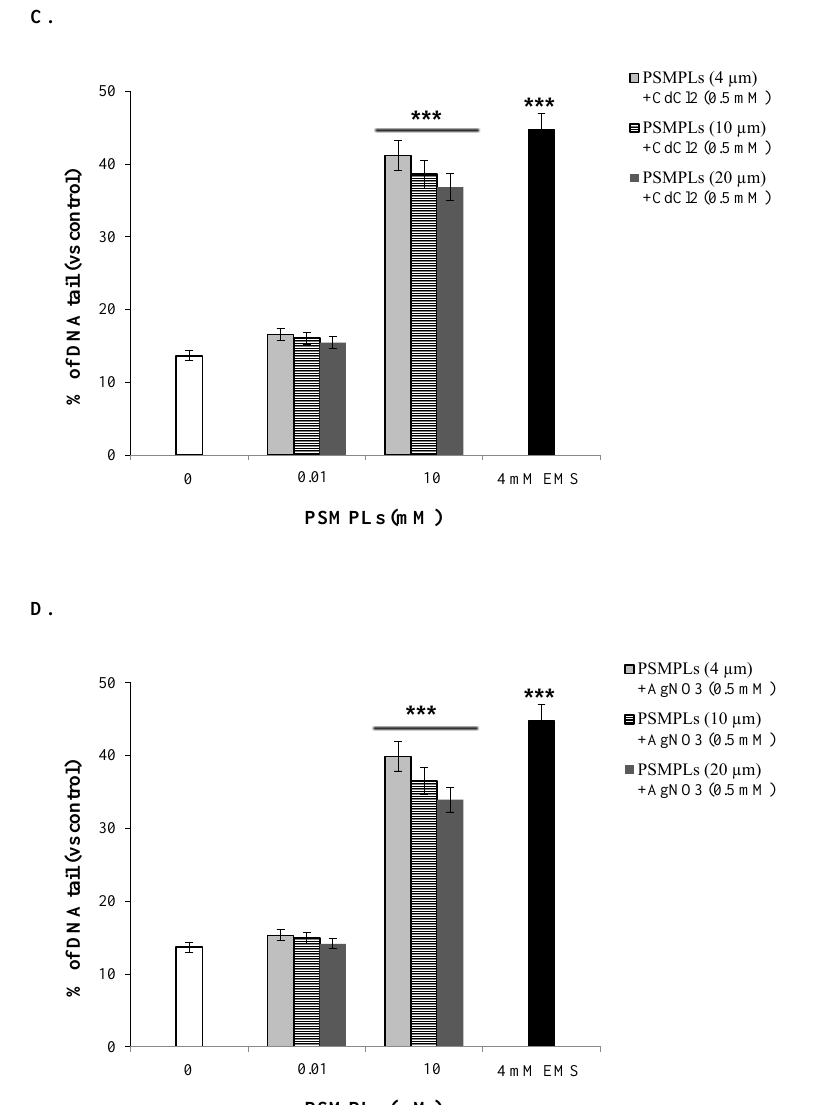
Figure 5. Genotoxic effects of PSMPLs ( A ), CdCl 2 and AgNO 3 ( B ), PSMPLs + CdCl 2 ( C ), and PSMPLs + AgNO 3 ( D ) in the Comet assay. Results indicate the % of DNA tail induced after the larvae were exposed to different doses of compounds for 24 h (three replicates were performed and 100 randomly selected cells were analyzed per treatment). Data represent the mean ± standard error (SE). EMS (4 mM) was used as positive control. *** p ≤ 0.001, as compared to the negative control by the Student’s t